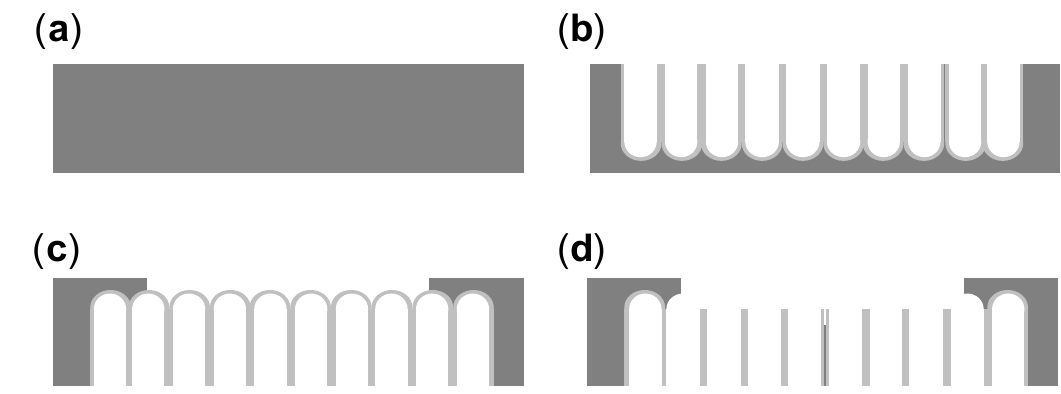
Figure 1. Schematic drawing of the synthesis of experimental nanoporous alumina structure (NPAS) samples: ( a ) Starting Al substrate; ( b ) nanoporous alumina structure obtained after two-step anodization method; ( c ) selective removal of unoxidized aluminum substrate; ( d ) removal of barrier layer and pore opening.